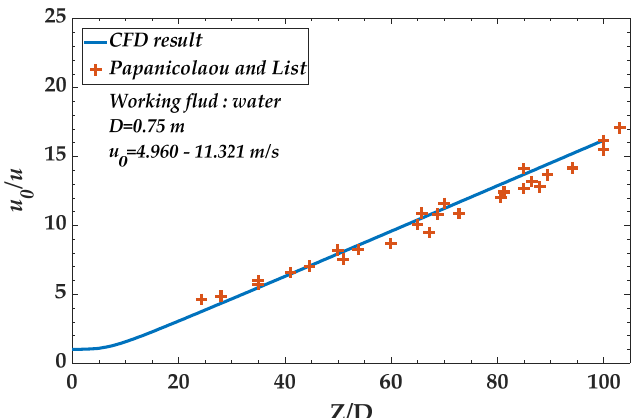
Figure 9. Comparison between the CFD results and the experimental data* (* reproduced from the work of Papanicolaou and List (1988) [27]).